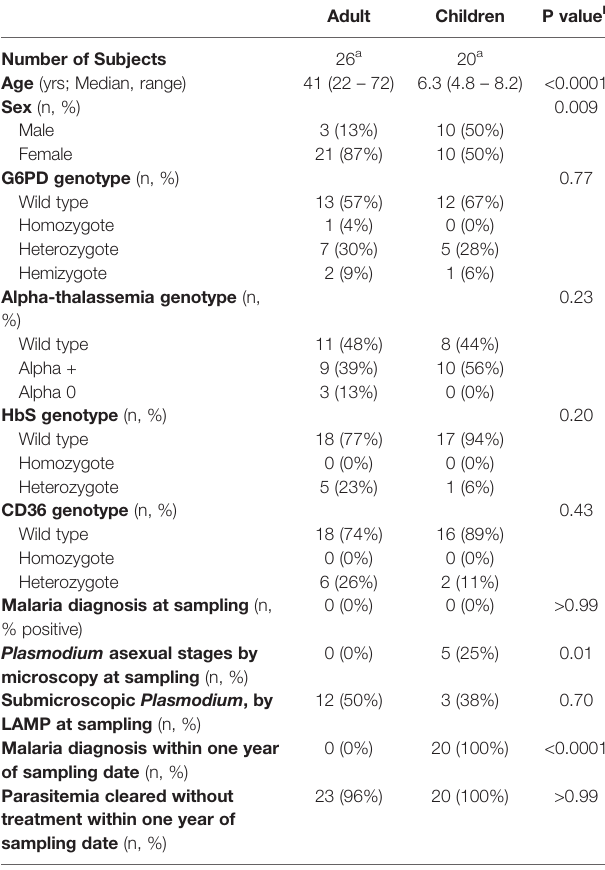
TABLE 1 | Demographic and clinical characteristics of study